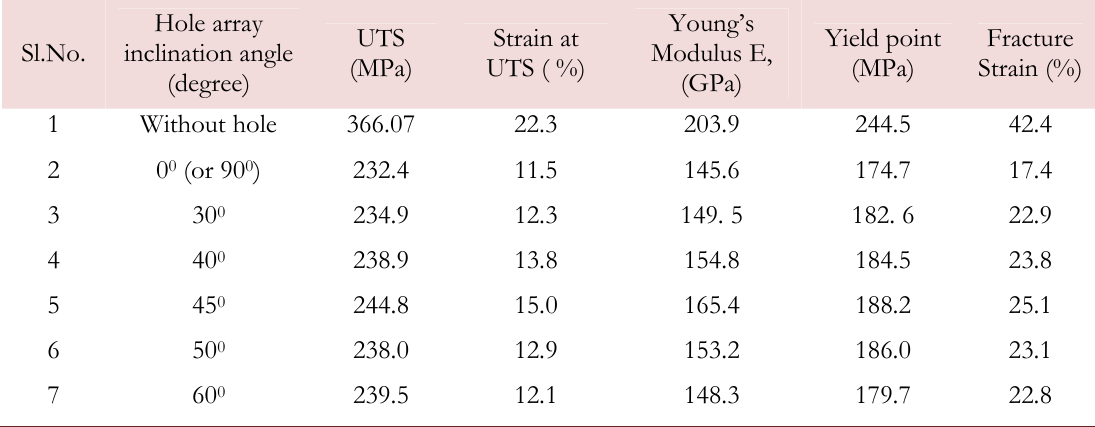
Table 2: Mechanical properties of rectangular specimen with hole.